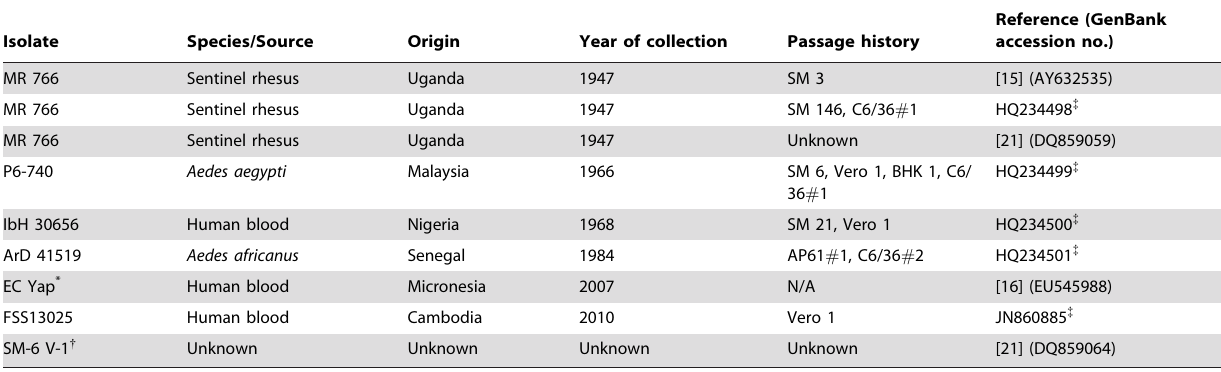
Table 2. Viruses used in this study.